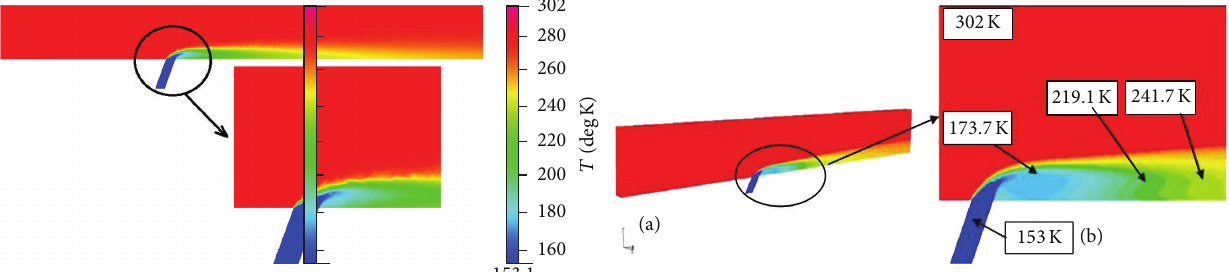
Figure 13: Comparison of static temperature contours of a single cylindrical hole.